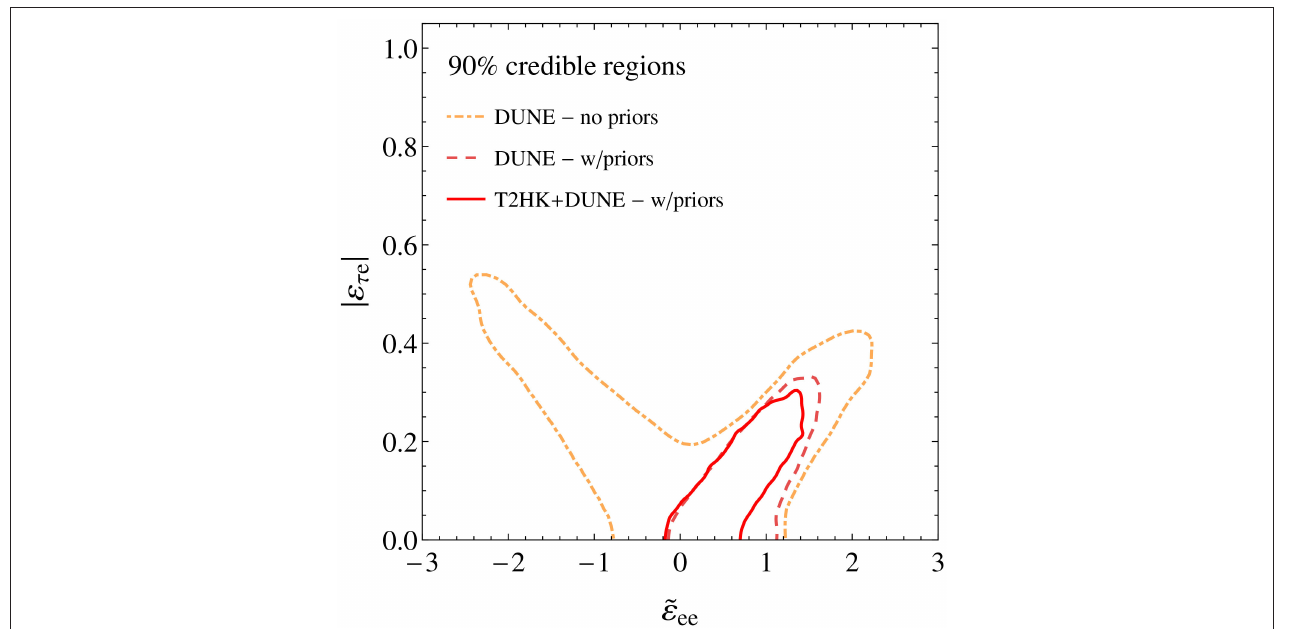
ǫ τ e ǫ ee ǫ ee ǫ µµ plane for DUNE and DUNE+T2HK (see Equation 17 for the definition of ǫ ). The phase of ǫ τ e is FIGURE 12 | 90% CL contours in the and | | ˜ = − allowed to vary. Contours with priors take into account the present bounds from various neutrino oscillation experiments. This plot is taken from Coloma [215], published under the terms of the Creative Commons Attribution Noncommercial License and therefore no copyright permissions were required for its inclusion in this manuscript. We would like to thank P. Coloma for sending the original